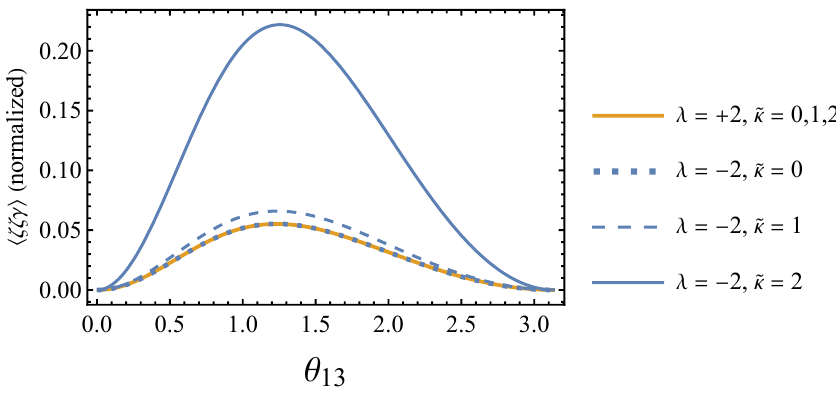
Figure 5 . The angular dependence of the mixed bispectrum h ζζγ i for different helicities and chemical potential choices. The horizontal axis is the angle θ 13 between momenta k 1 , k 3 . The vertical axis is the mixed bispectrum normalized by ( k 1 /k 3 ) 9 / 2 k 6 h ζ ( k 1 ) ζ ( k 2 ) γ λ ( k 3 ) i 0 / ρH 5 . The 3 MM 2 p ˙ φ 0 momentum ratio is held fixed as k 1 /k 3 = 5 , with the mass of the spin-2 particle taken to be µ = 3 . We observe the characteristic P 2 (cos θ 13 ) dependence of the massive spin-2 particle. In addition, 2 the chemical potential introduces a bias for the two helicities, and the λ = − 2 mode is enhanced in